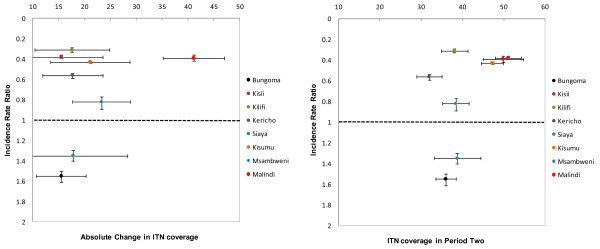
Relationship between changes in the incidence rate of malaria admissions between period one and two (Incidence rate ratio) and equivalent absolute changes in ITN coverage across 8 hospital catchments (Left- absolute difference in ITN coverage between period one and two; Right - ITN coverage in the follow-up period).